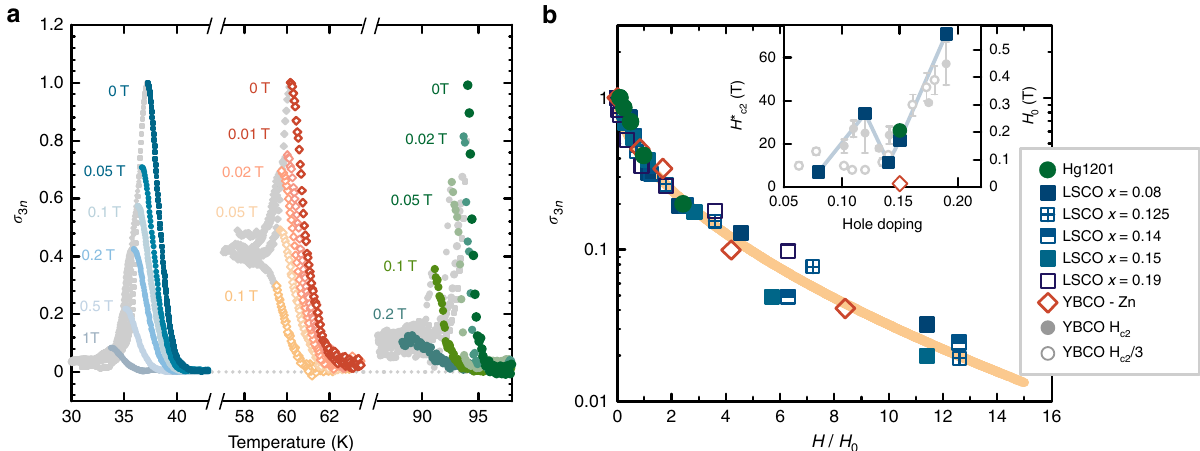
Fig. 3 In fl uence of external c -axis magnetic fi eld on in-plane nonlinear response. a Nonlinear conductivity at various applied fi elds for Hg1201, YBCO-Zn, and LSCO-0.15, normalized to the zero- fi eld peak values. b Scaling of the nonlinear conductivity with magnetic fi eld. Symbols indicate peak values of σ 3 upon subtracting the high- fi eld step and normalizing to the zero- fi eld values. The orange line is the result of an effective medium calculation for the percolation model (see text). Inset: suppression fi eld H 0 compared with previous results for H c2 for YBCO obtained using muon spin rotation 44 (full circles) and transport 45 (empty circles). The light blue line is a guide to the eye. Errors (1 s.d.) in σ 3 n and H 0 are within the symbol